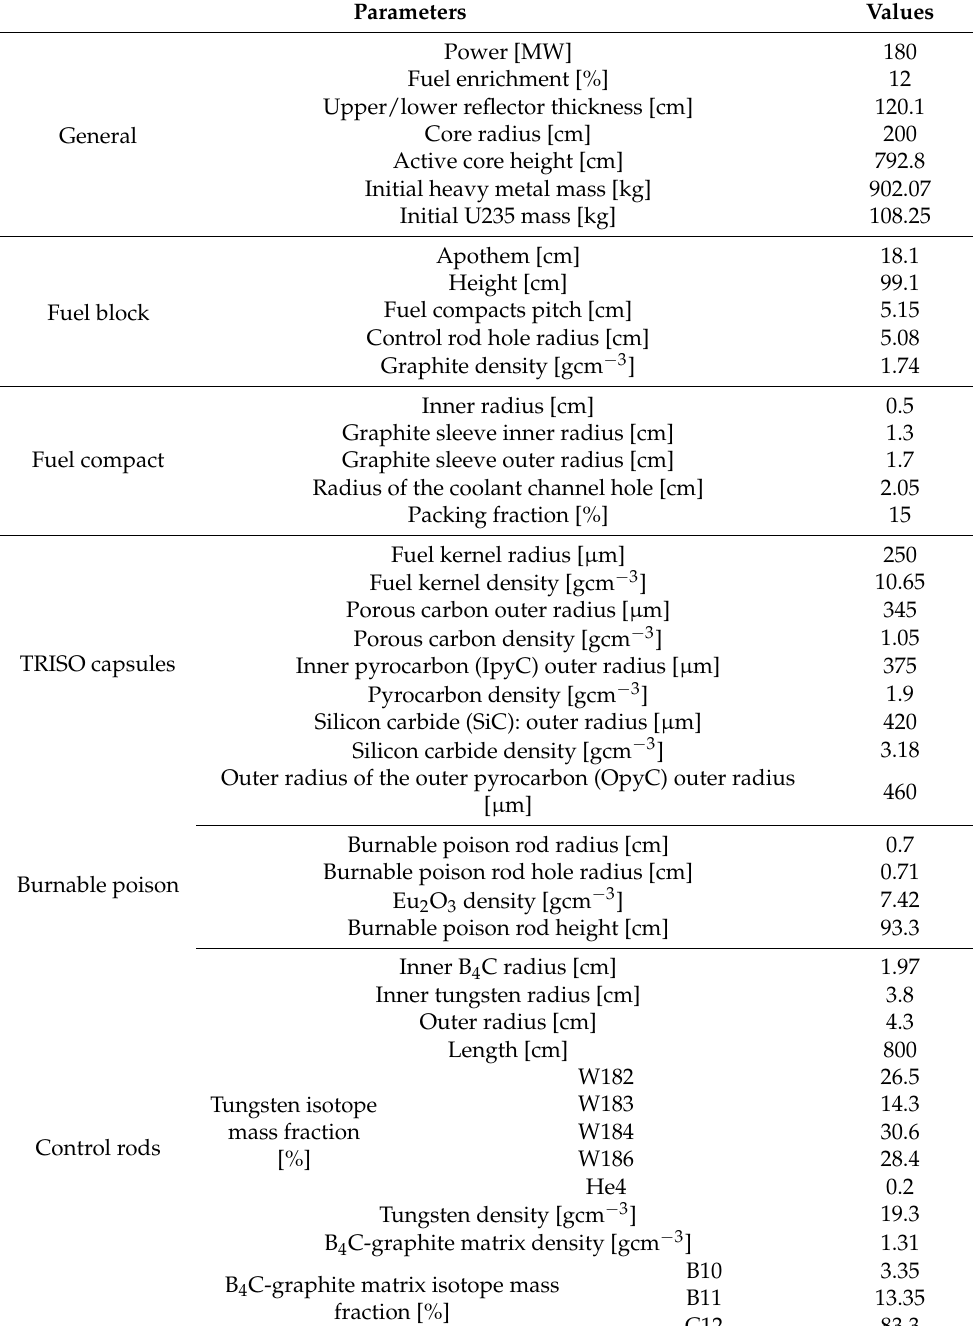
Table 1. Specifications of the Go_HTR